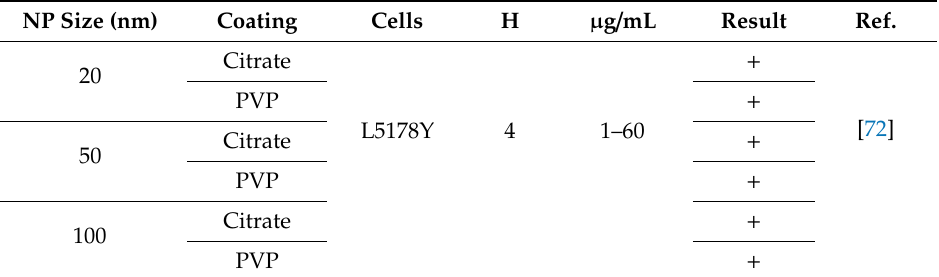
Table 1. In vitro mouse lymphoma assay